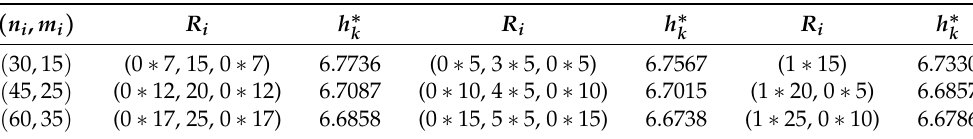
Table 8. The average optimal transformed stress level h ∗ sizes ( n i , m i ) and different censoring schemes R i